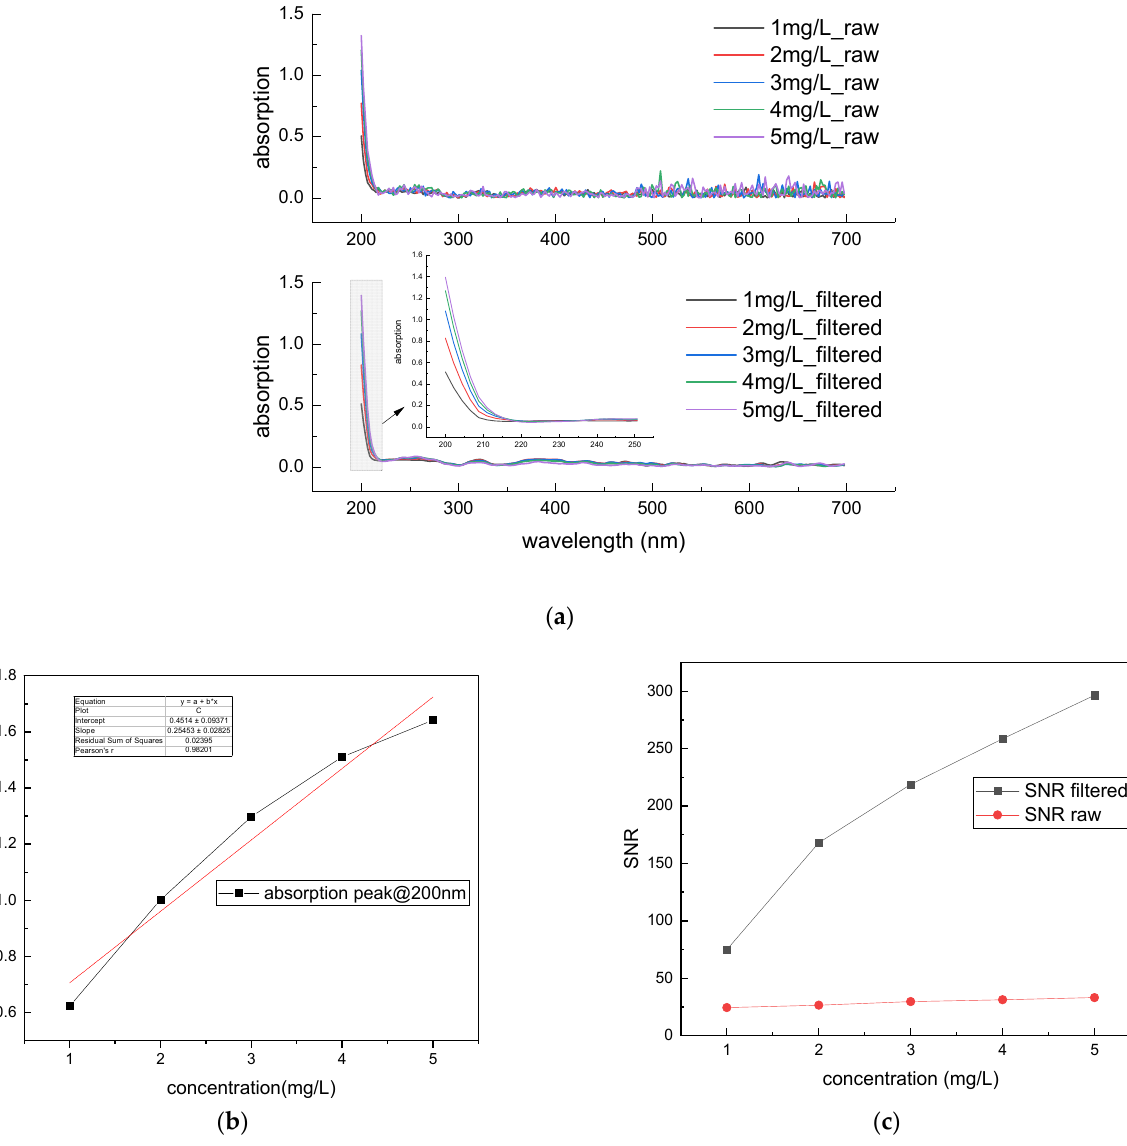
Figure 9. ( a ) Filter result for absorption spectrum of nitrate in concentration from 1 mg/L~5 mg/L. ( b ) Linear fitting result between nitrate concentration and sum of the absorption value at the wave- length of 200 nm. ( c ) SNR comparison for absorption spectrum of nitrate.